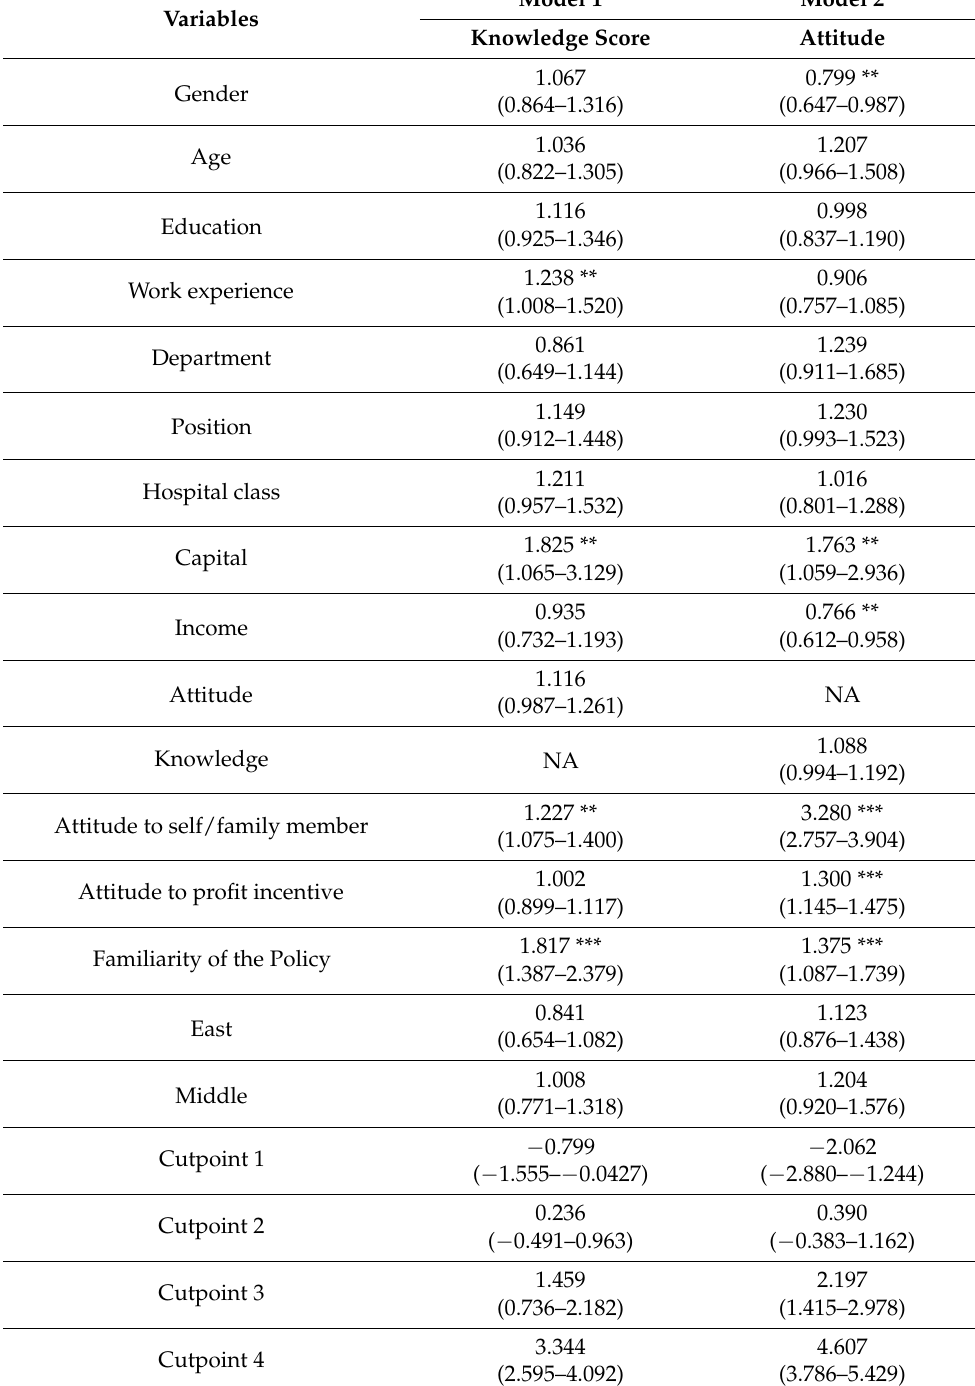
Table 3. Ordered logistic regression analysis of factors associated with knowledge score and